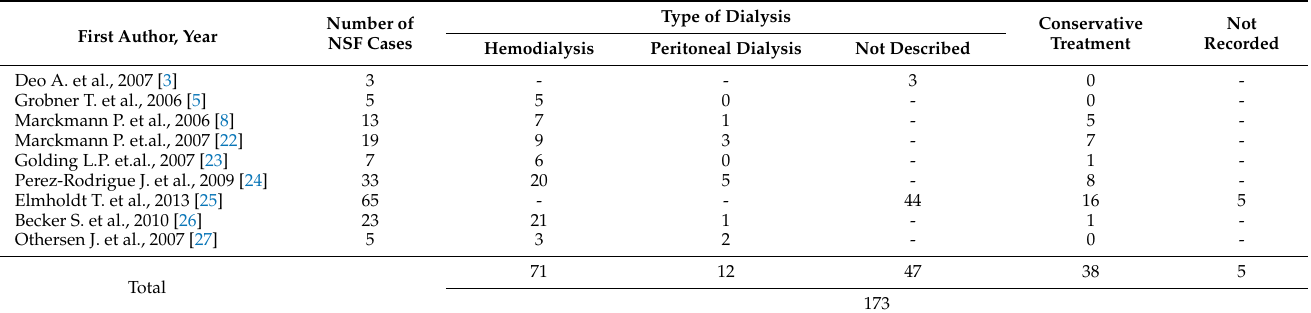
Table 7. Treatment of kidney